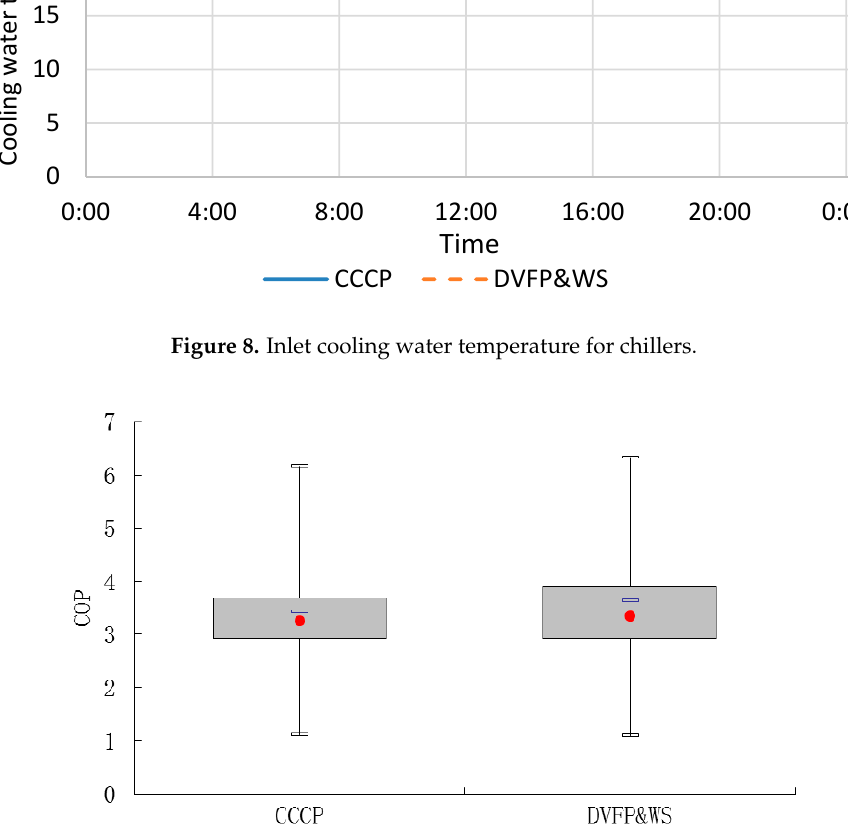
Figure 9. Box chart of chiller coefficient of performance (COP) for the two different systems.